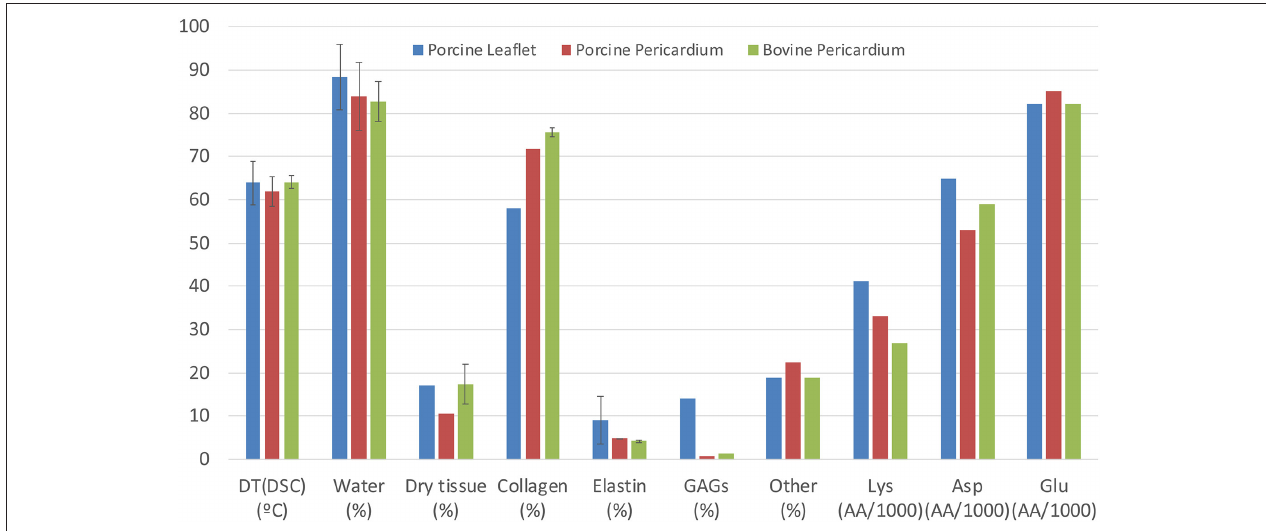
FIGURE 2 | Comparison of composition and properties of porcine and bovine pericardium with those of porcine aortic leaflets, including denaturation temperature (by differential scanning calorimetry), water content and dry tissue content. Collagen, elastin and other constituents are expressed as percentage of dry content, while amino acid content for Lys, Asp, and Glu are in amino acids per 1,000 residues [compiled from Bezuidenhout et al. (44); Zouhair et al. (49)].